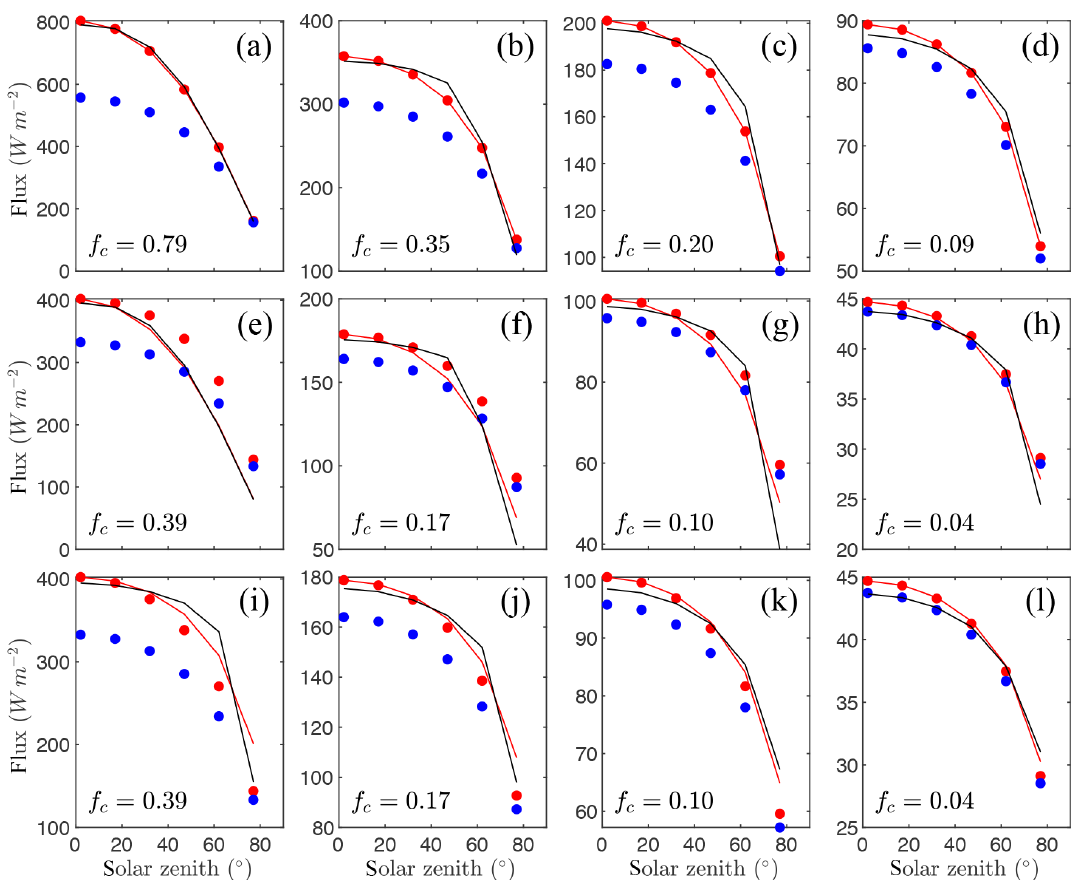
Figure 4. Flux of intercepted radiation versus solar zenith angle for a half-diurnal cycle in a canopy of solid spheres (see Fig. 3a). Varying ground cover fractions f c were simulated (rows in figure) for three different plant arrangements: (a–d) randomly spaced, (e–h) east–west row orientation, and (i–l) north–south row orientation. The exact flux is given by the output of the 3-D model (black line), which is compared against the 1-D models BINOM (red line), NIL99_B (red circle), and NIL99_P (blue